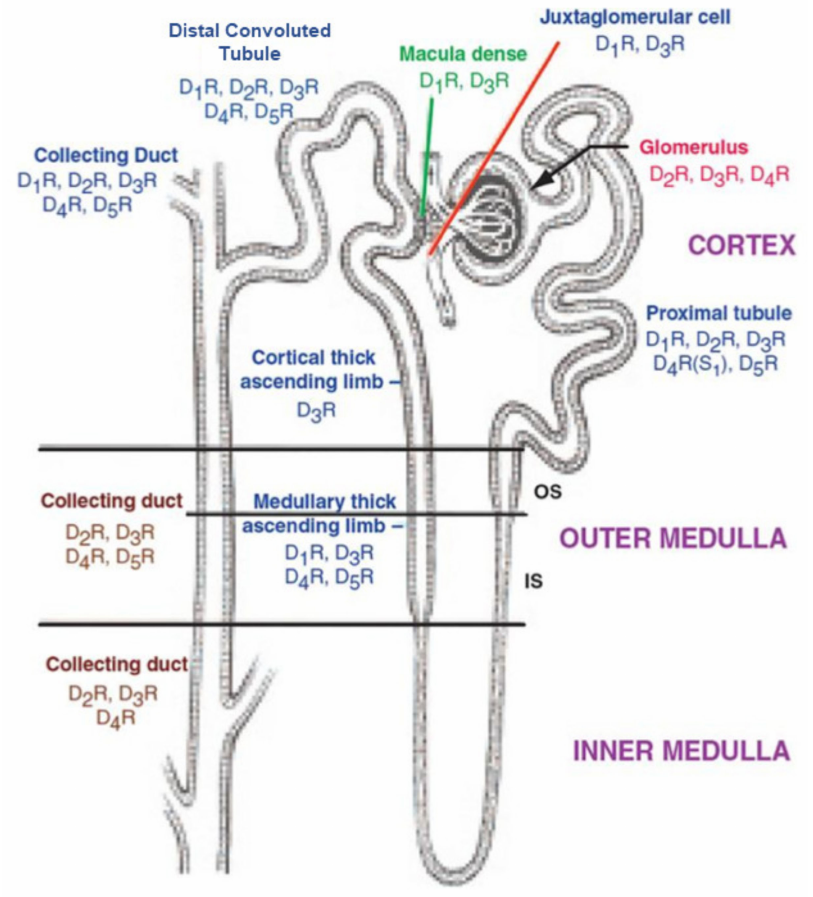
Figure 2. Diagram displaying the distribution of dopamine receptor subtypes (D 1 R-D 5 R) along the parts of a nephron. OS: outer stripe; IS: inner stripe; S 1 : first segment of the proximal tubule